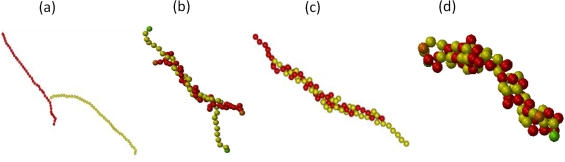
Twisted, DNA-like polyelectrolyte complexes formed by electrostatic attraction of two oppositely charged linear macromolecules with N = 40 at τ̂ = 0 (a), τ̂ = 10500 (b), τ̂ = 60000 (c) and τ̂ = 120000 (d), where τ̂ is given in Lennard-Jones units. The interaction strength is ξ = 8 [222,223].